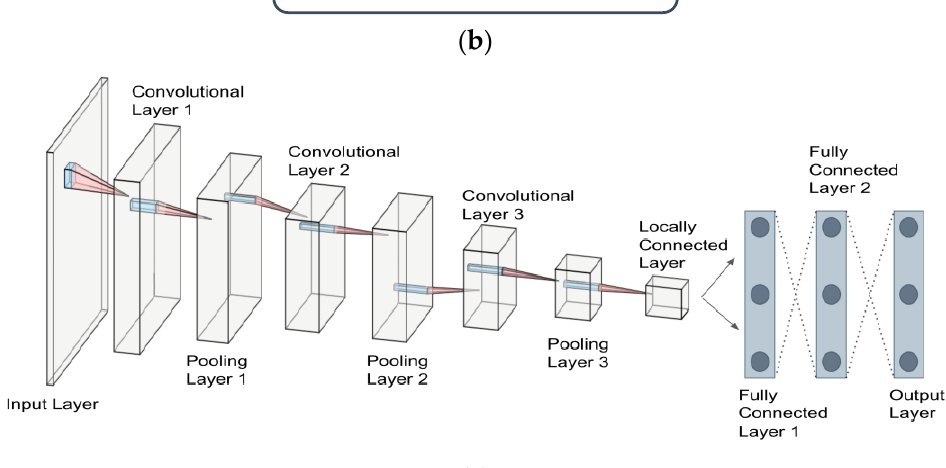
Figure 4. ( a ) personality classification architecture ( b ) EEG-based emotion classification model ( c ) proposed network model with three hidden layers. Figure 4c, about a second-layer neuron named JJ. Its activation is: